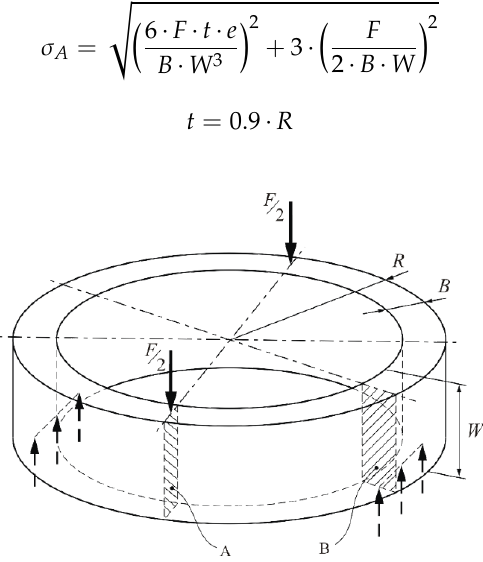
Figure 1. The scheme of the ring bending in the axial direction, with both sections A and B [4–8].